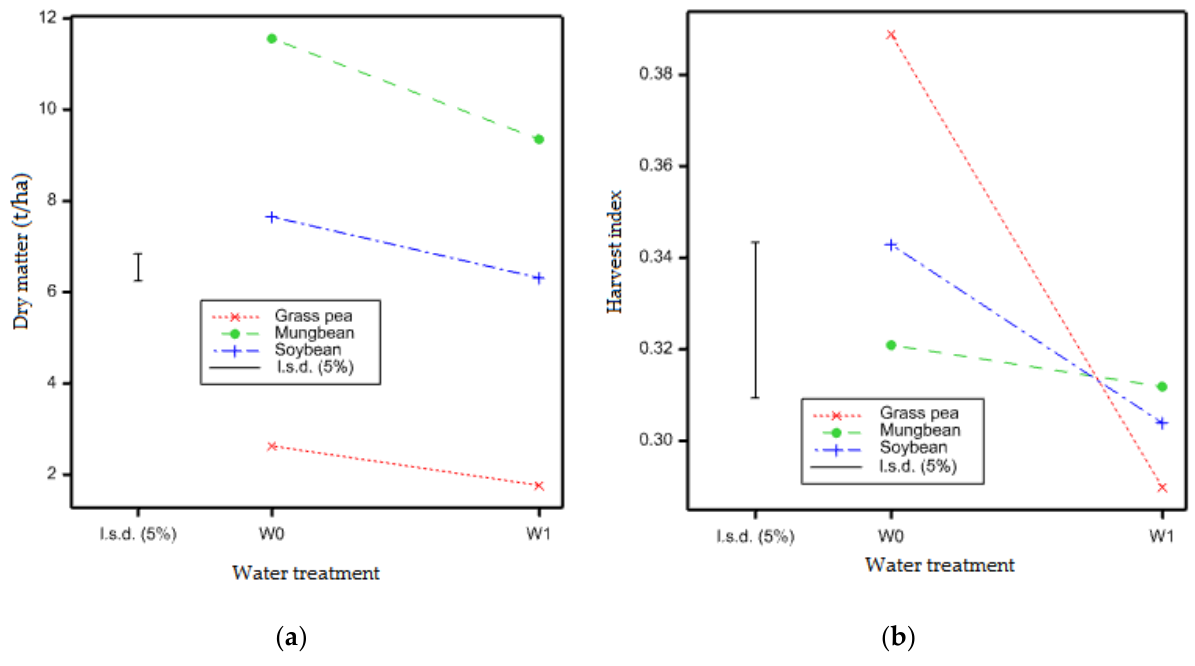
Figure 6. Water treatment × species interaction for ( a ) dry matter production ( p < 0.012) and ( b ) harvest index ( p < 0.004) at the Laleia site in 2019.